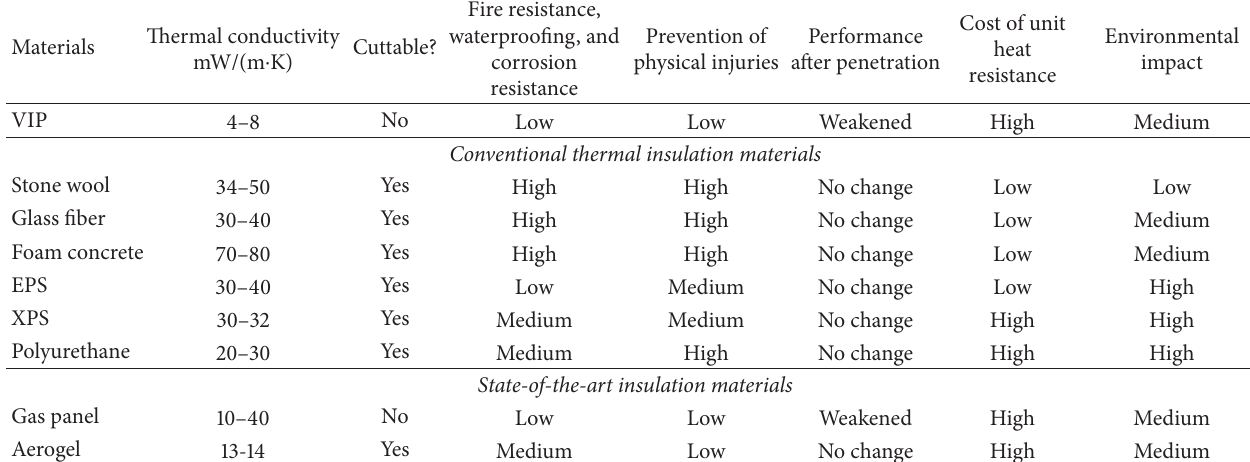
Table 2: Comparison of the thermal performance of VIP and other thermal insulation materials [4].